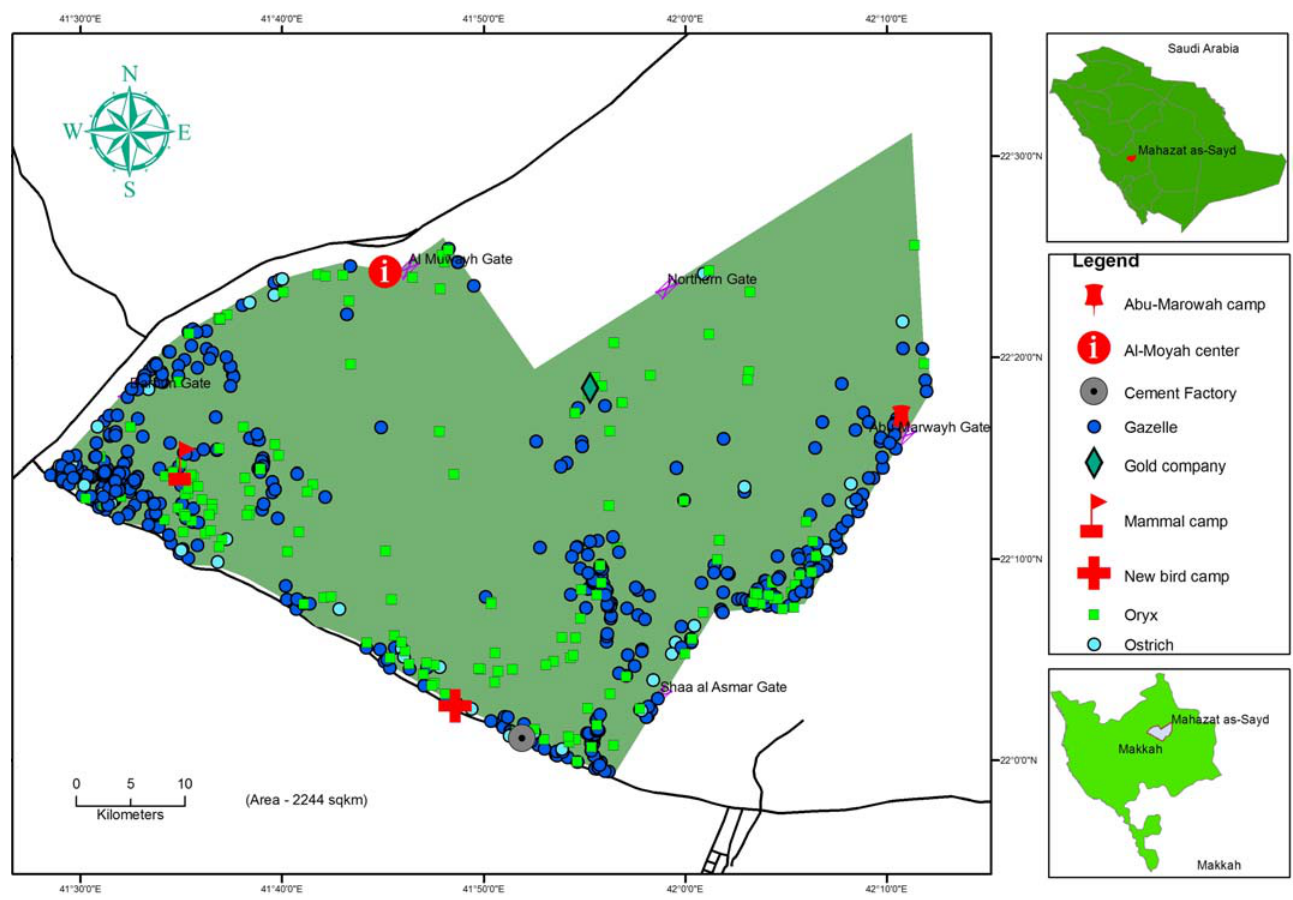
Image 1. Locations of carcasses of Arabian Oryx, Arabian Sand Gazelle and Ostrich in Mahazat as-Sayd Protected Area in Saudi Arabia during 2006, 2007 and 2008. (Most of the carcasses were recorded near the northwestern, southern and southeastern parts of the reserve mainly under green acacia or mearua trees, which were sites with typical thermal cover that are required for ungulates at Mahazat during summer months; while in the northeastern part very few carcasses were recorded which could be due to less vegetation in that